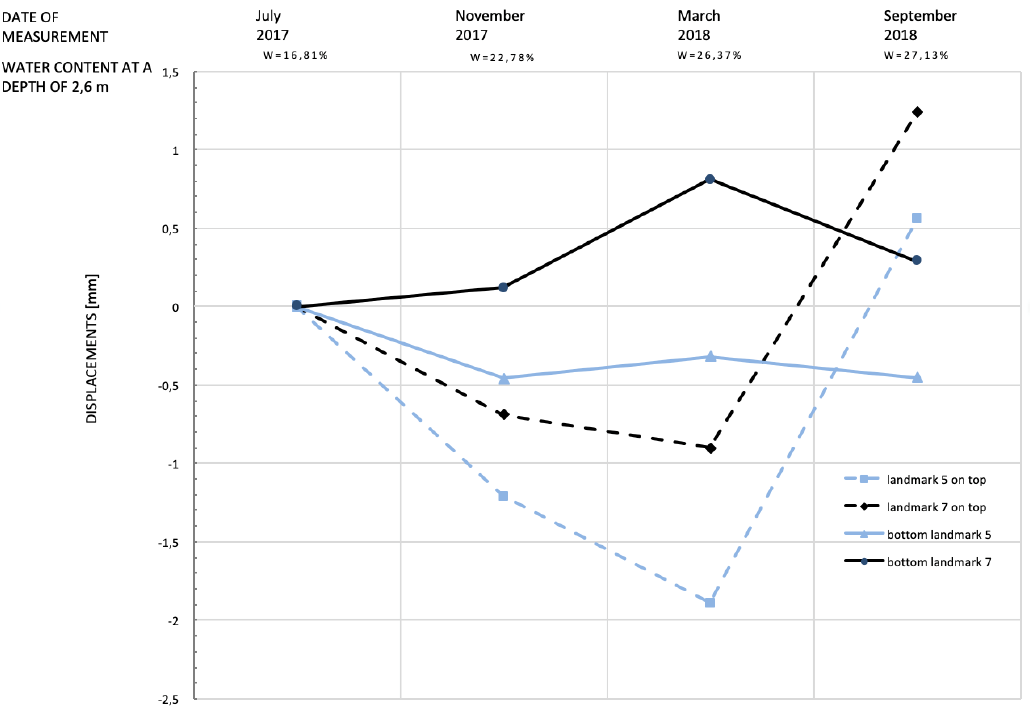
Figure 9. Vertical relative displacements’ dependence on the ambient temperature.